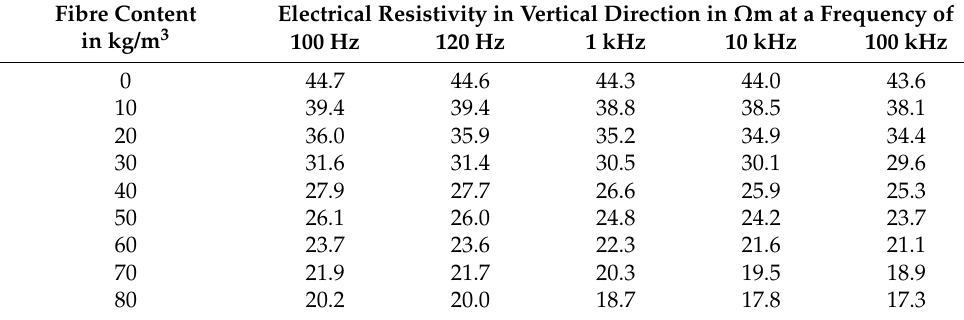
Table A24. Results of the resistivity measurements of the concrete mixture 32-60-300-00-F1. Fibre